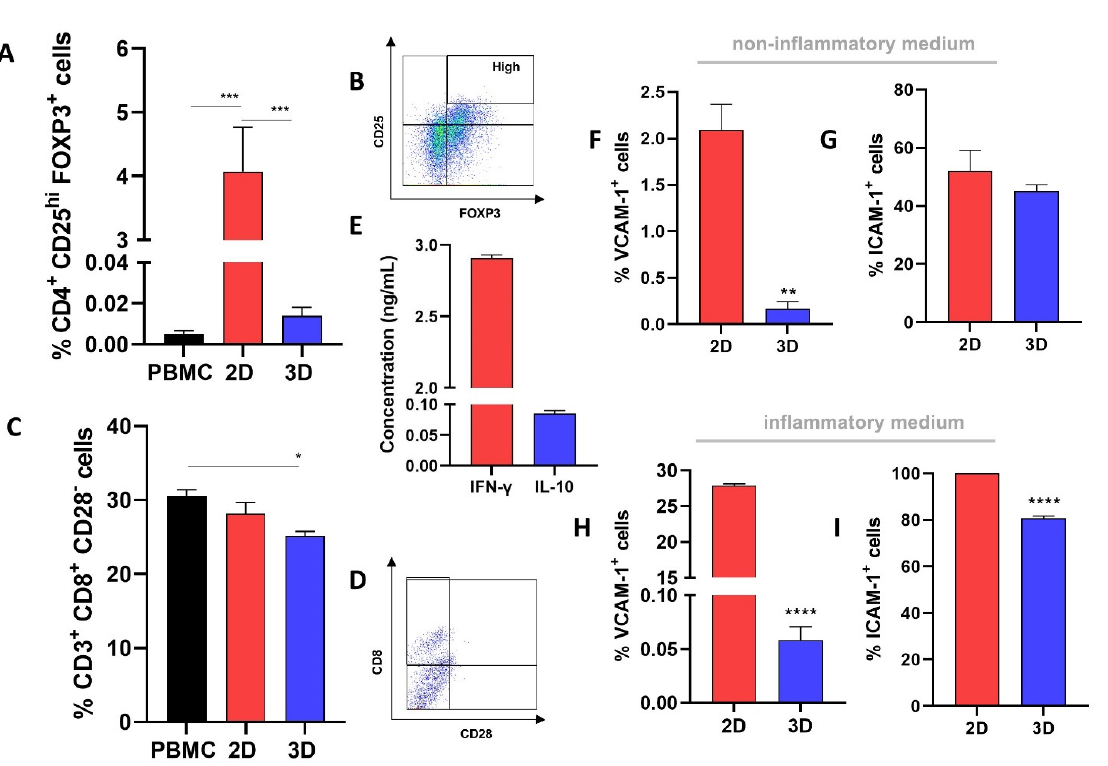
Figure 3. Treg and adhesion molecule induction by 2D ‐ MSCs and 3D ‐ MSCs. ( A ) Enhancement of CD4 + CD25 high FOXP3 + Tregs cells by 2D ‐ MSCs. ( B ) Gating strategy for analysis of CD25 hi FOXP3 + population in CD4 cells. ( C ) Reduction of CD8 + CD28 − Treg cells in PBMCs co ‐ cultured with 3D